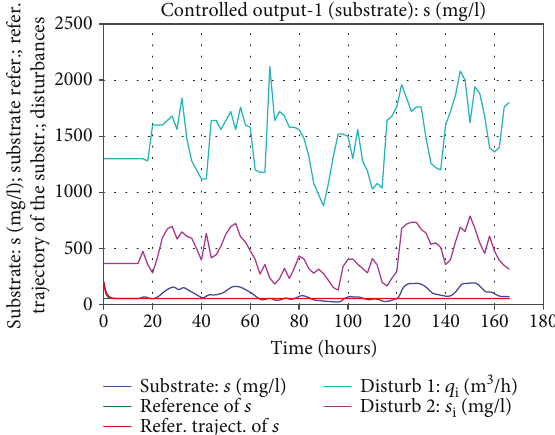
Figure 13: Substrate in the e ffl uent and disturbances (case